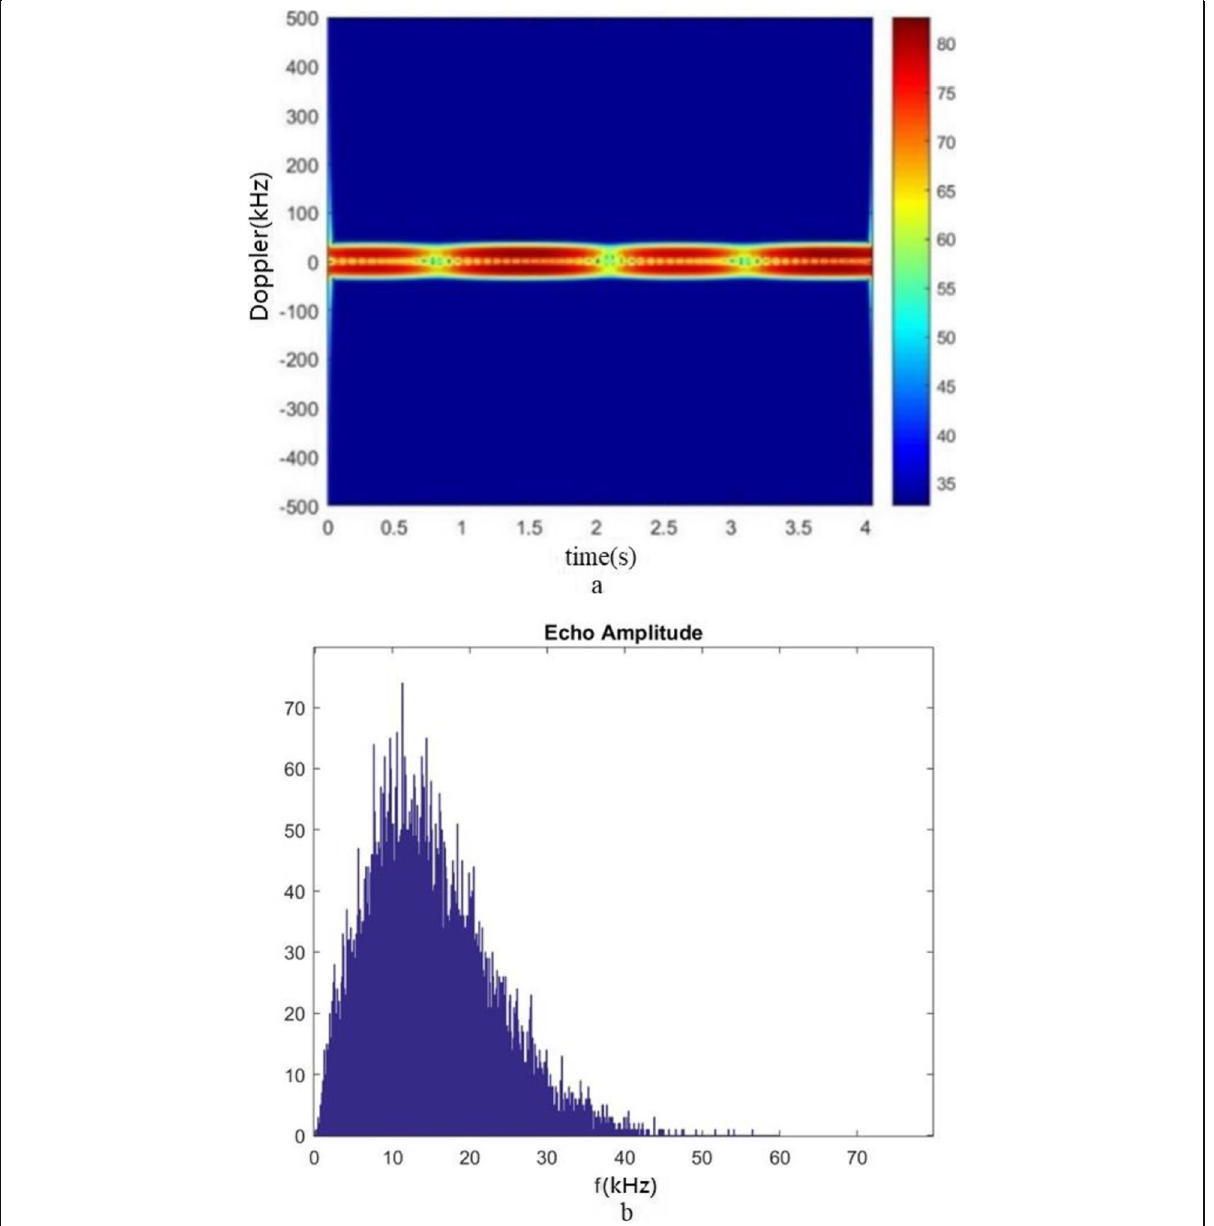
Fig. 10 Micro-Doppler spectrum of the chaff cloud: a the energy spectrum of the chaff cloud and b the echo amplitude of the chaff